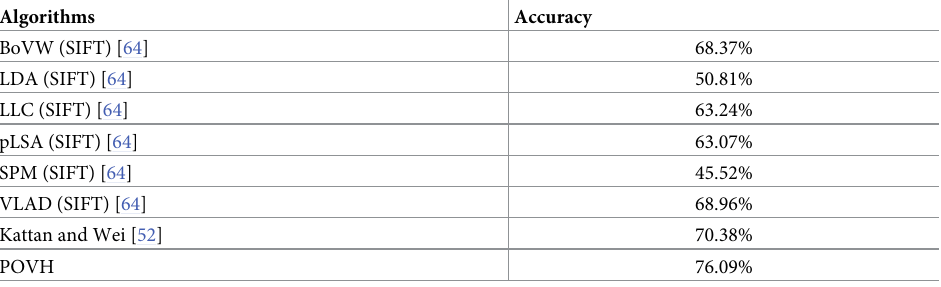
Table 5. Classification accuracy comparison while using AID